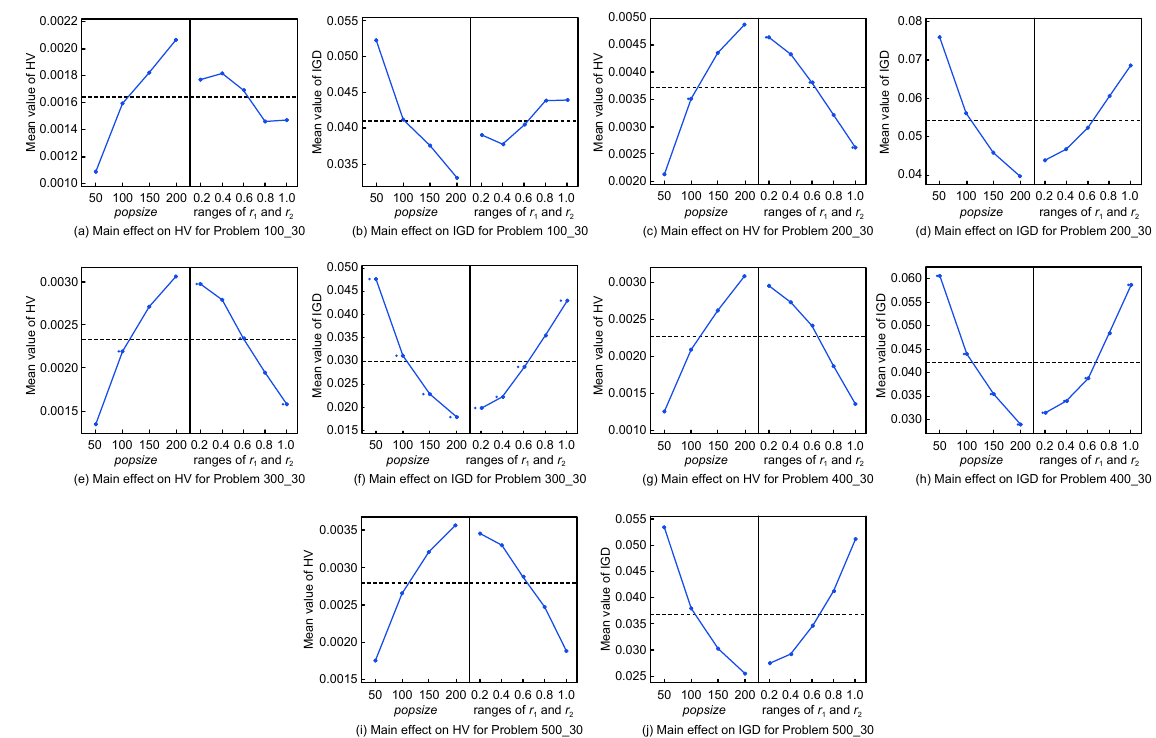
Fig. 7 Main effect of each parameter for different instances. The horizontal coordinates of the left and right are popsize and rangs of r and r , respectively, and the vertical coordinate is the mean value of HV or 1 2